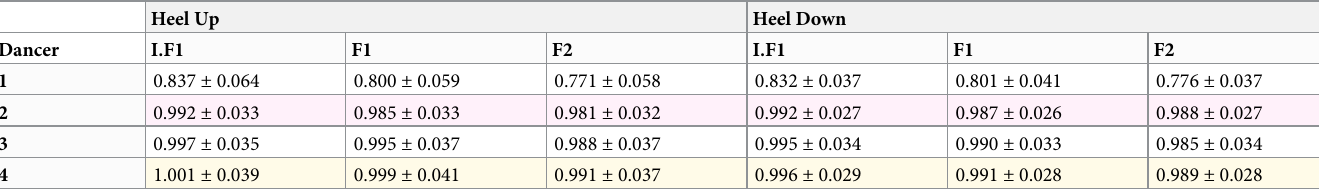
Table 3. Ratios of inter-onset intervals with the inter-beat interval. Heel